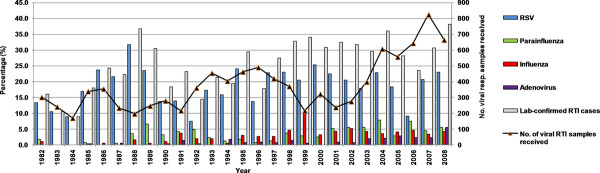
Proportions of respiratory viruses detected between 1982 and 2008. The detection of each respiratory virus as a proportion of the total number of positive respiratory virus samples is shown.